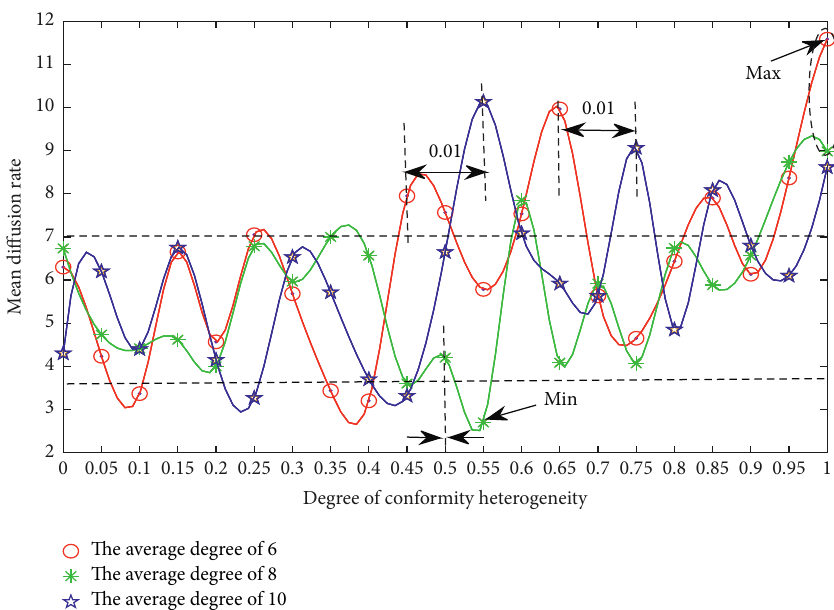
Figure 8: Influence of conformity heterogeneity on mean diffusion rate based on different network topologies.